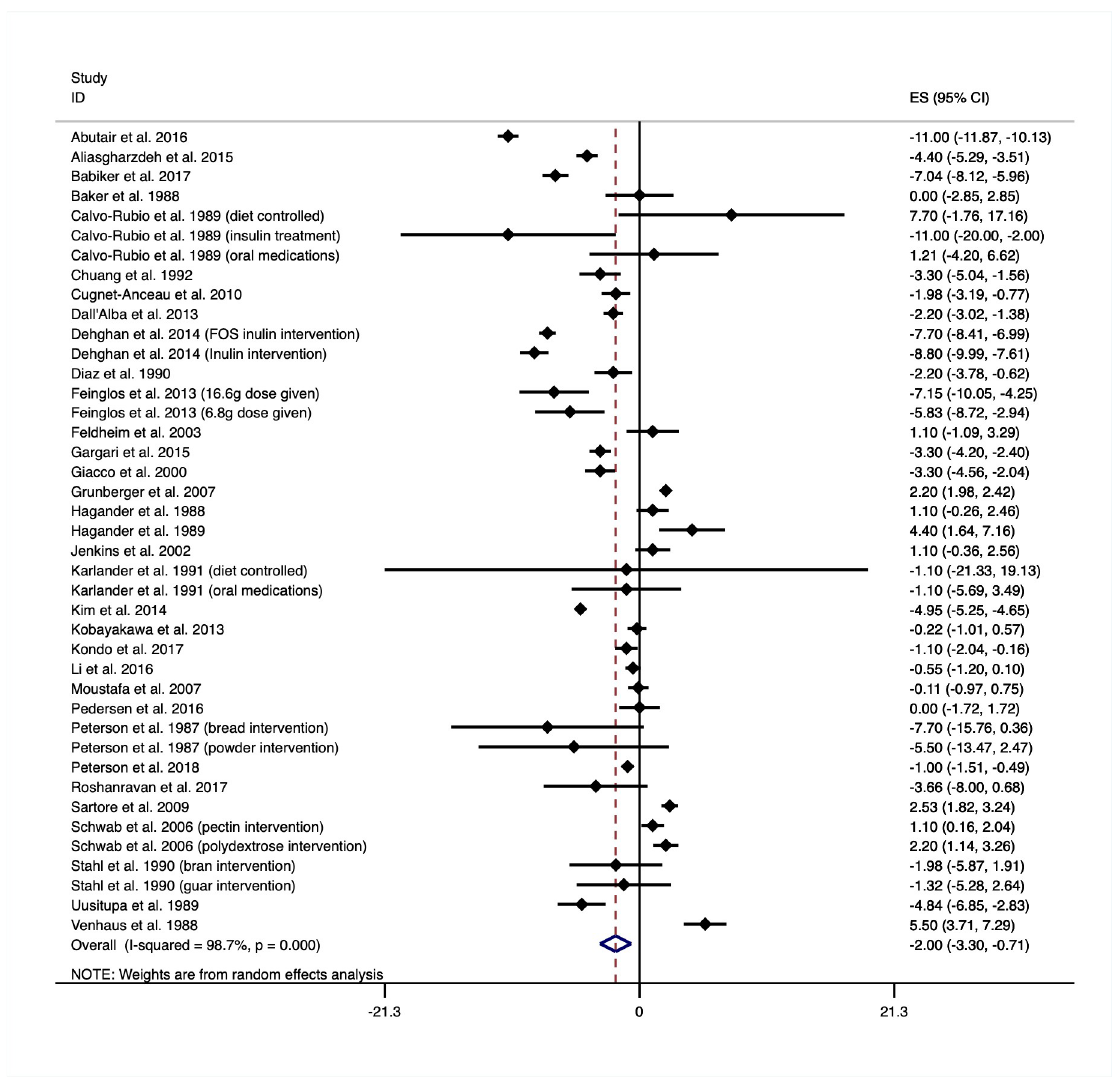
Fig 3. Mean difference in glycated haemoglobin (mmol/mol) between intervention and control groups from trials of increasing fibre intakes. Negative values show a decrease in HbA1c when increasing fibre intakes (the intervention). Intervention description is shown in brackets next to the first author’s name and year published in which a trial reported on multiple eligible intervention arms. Medication regimen is also shown in brackets in which the results were reported separately and not as a mean result. ES, effect size; FOS,